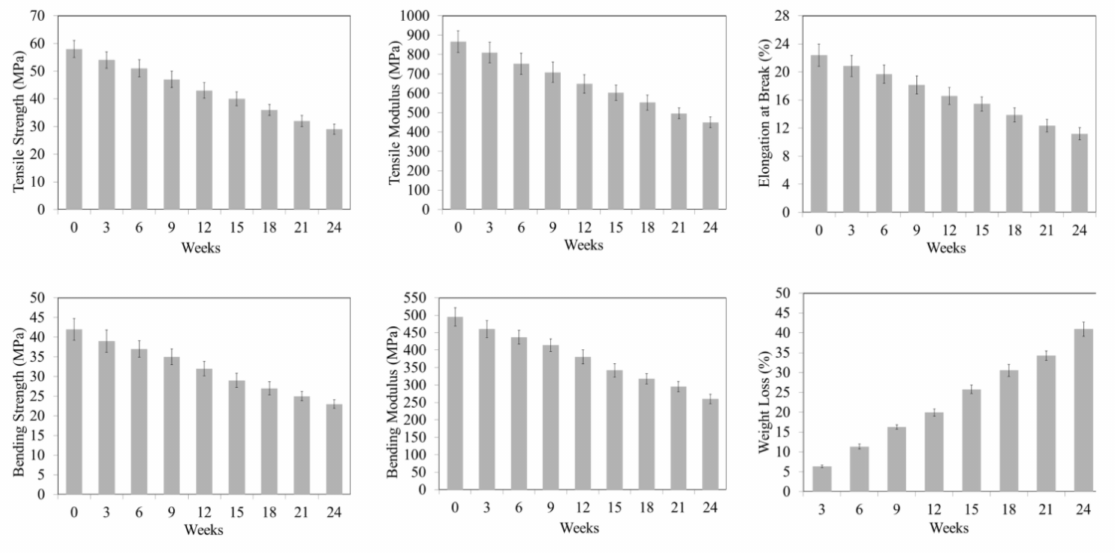
Figure 5. Soil degradation test of the